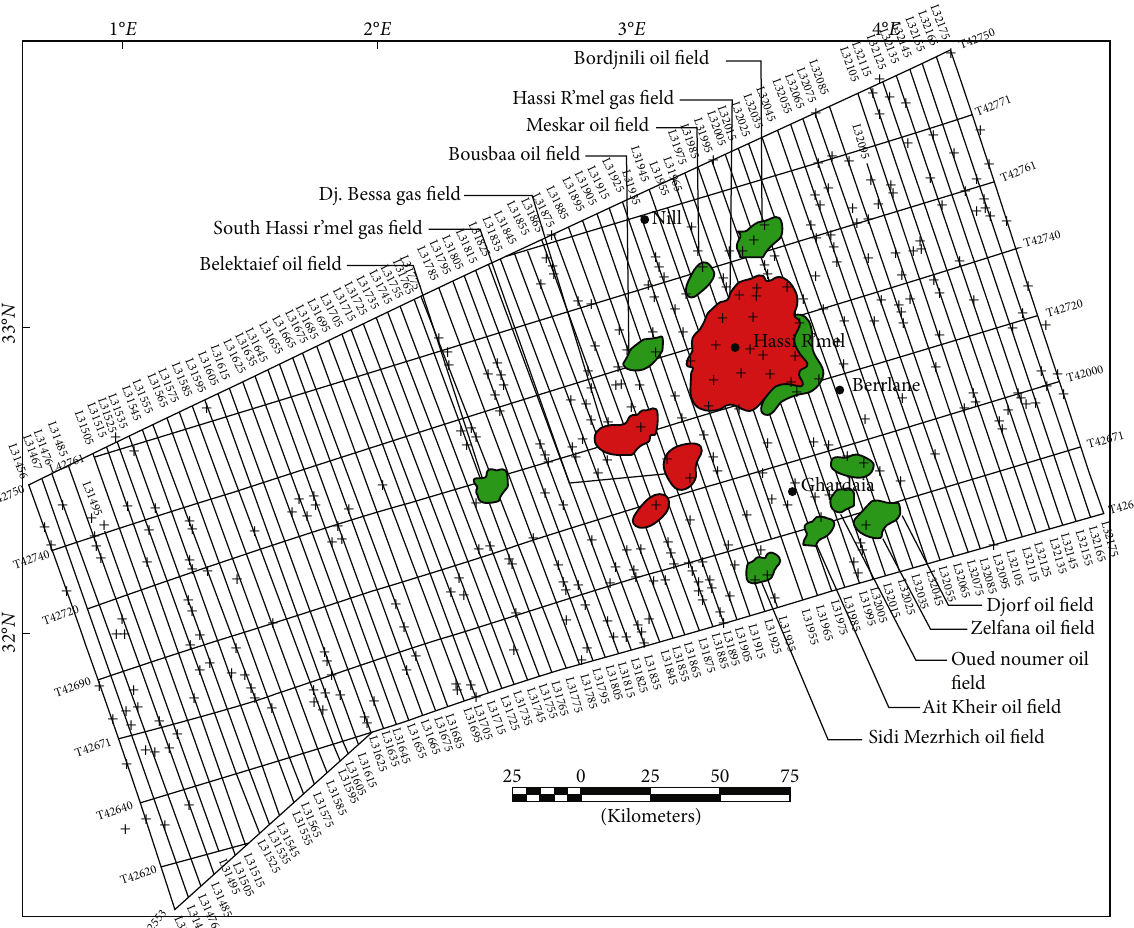
Figure 8: Black crosses represent the location of center-points of picked AS-SRM anomalies (the amplitude threshold for AS is 1.5nT/km); red polygons represent the gas fi elds, and green polygons represent the oil fi elds